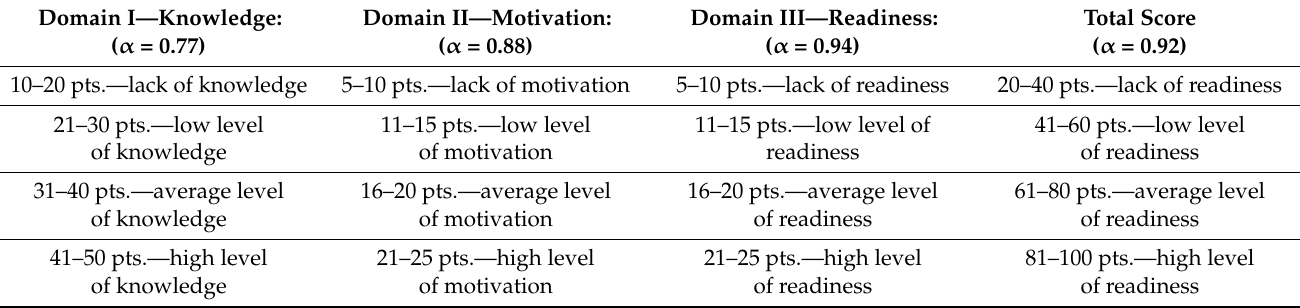
Table 2. The key to domain-specific assessment for NPWT readiness in